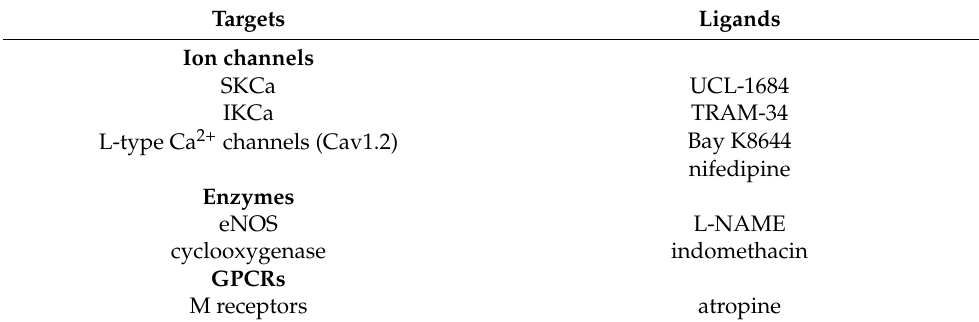
Table 1. Target proteins investigated in the 3-hydroxyphenylacetic acid(3-HPAA) mechanistic studies and the ligands used in the ex vivo experiments on the porcine coronary